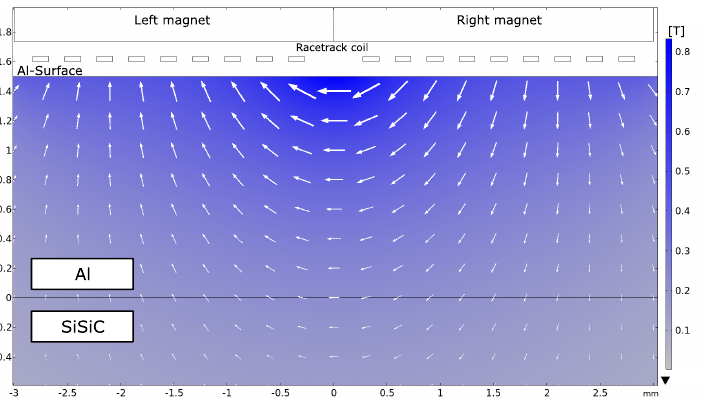
Figure 6. Simulated static magnetic flux density generated by a SmCo block magnet on top of the racetrack coil. Under the center of the right and left magnet, the magnetic flux density has a normal direction with respect to the aluminum surface. Beneath the center of the racetrack coil, the direction of the magnetic flux density is parallel to the surface and has the strongest